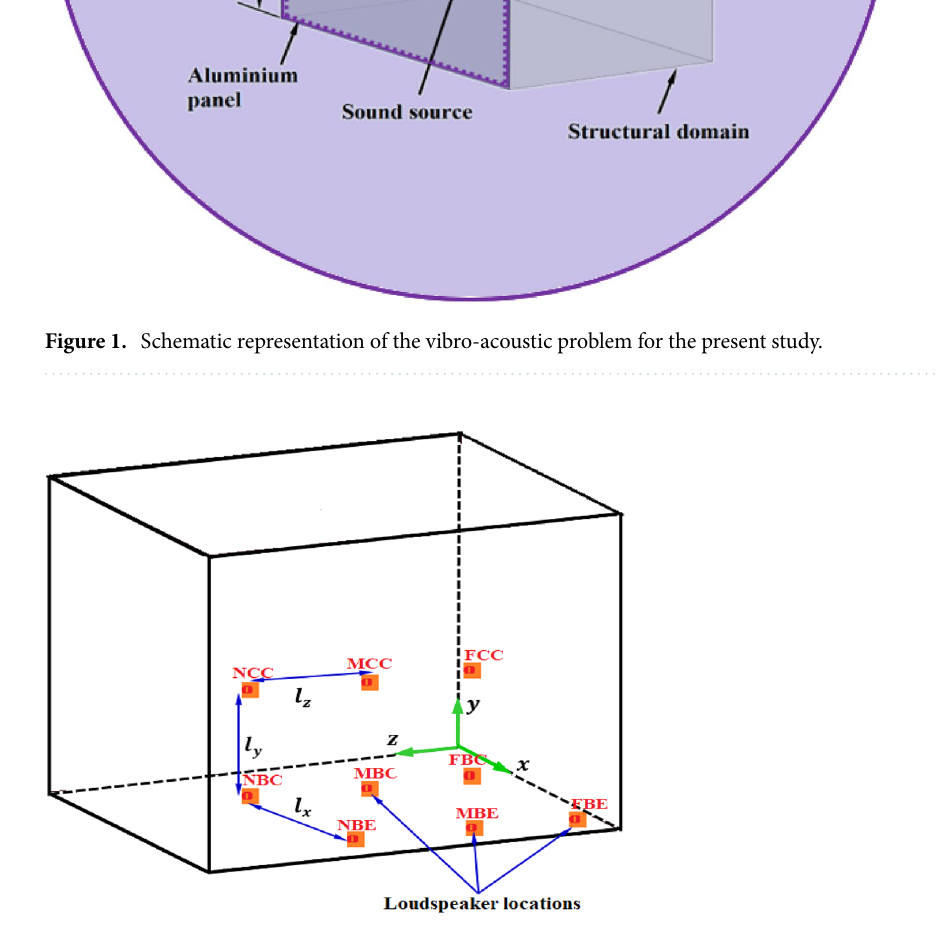
Figure 2. Representation of various designated locations of loudspeaker inside a rigid